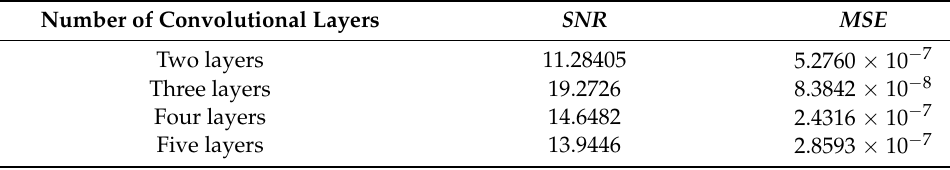
Table 2. The comparison experiment of the number of convolutional layers.